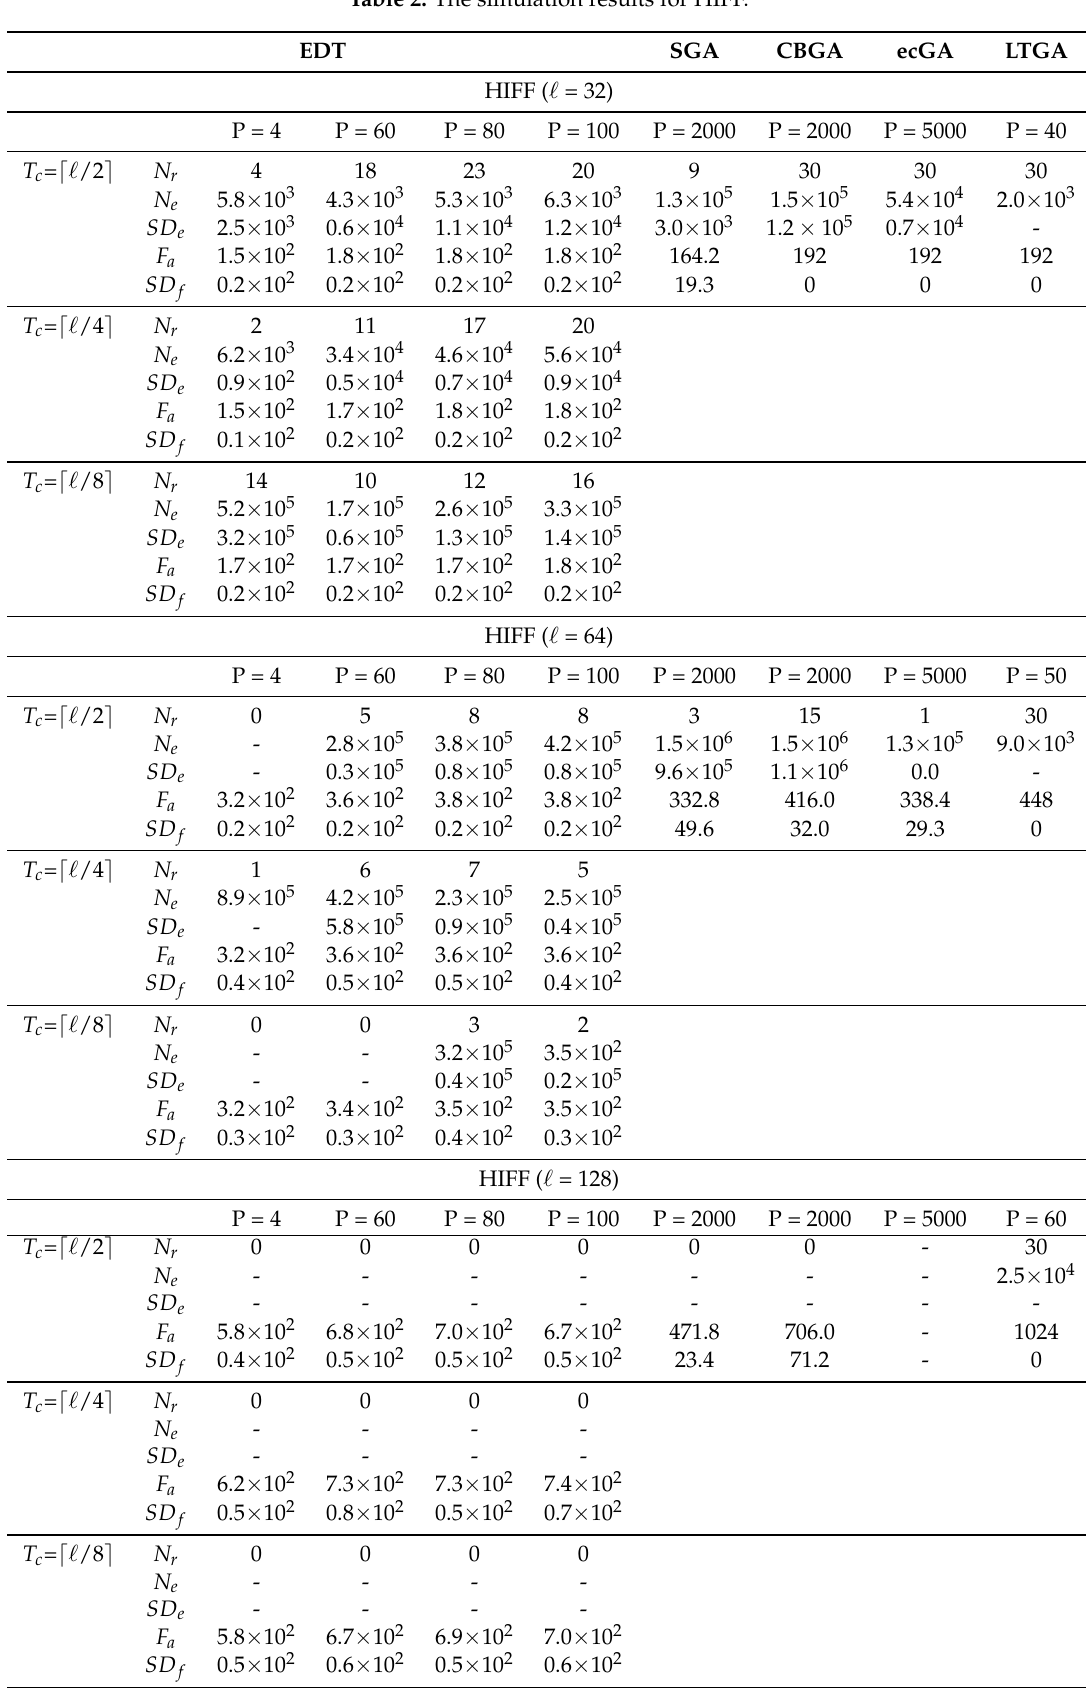
Table 2. The simulation results for